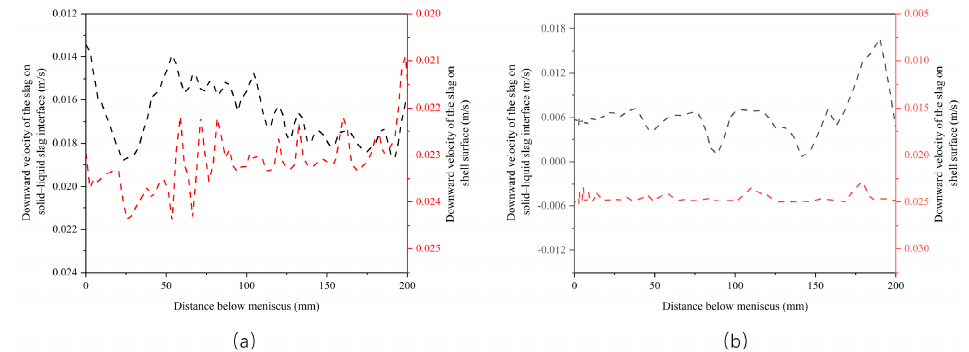
Figure 13. The downward velocity of the slag on solid–liquid slag interface and the downward ve- locity of the slag on shell surface ( a ) with 𝑡 (cid:3041) , ( b ) without 𝑡 (cid:3041) .